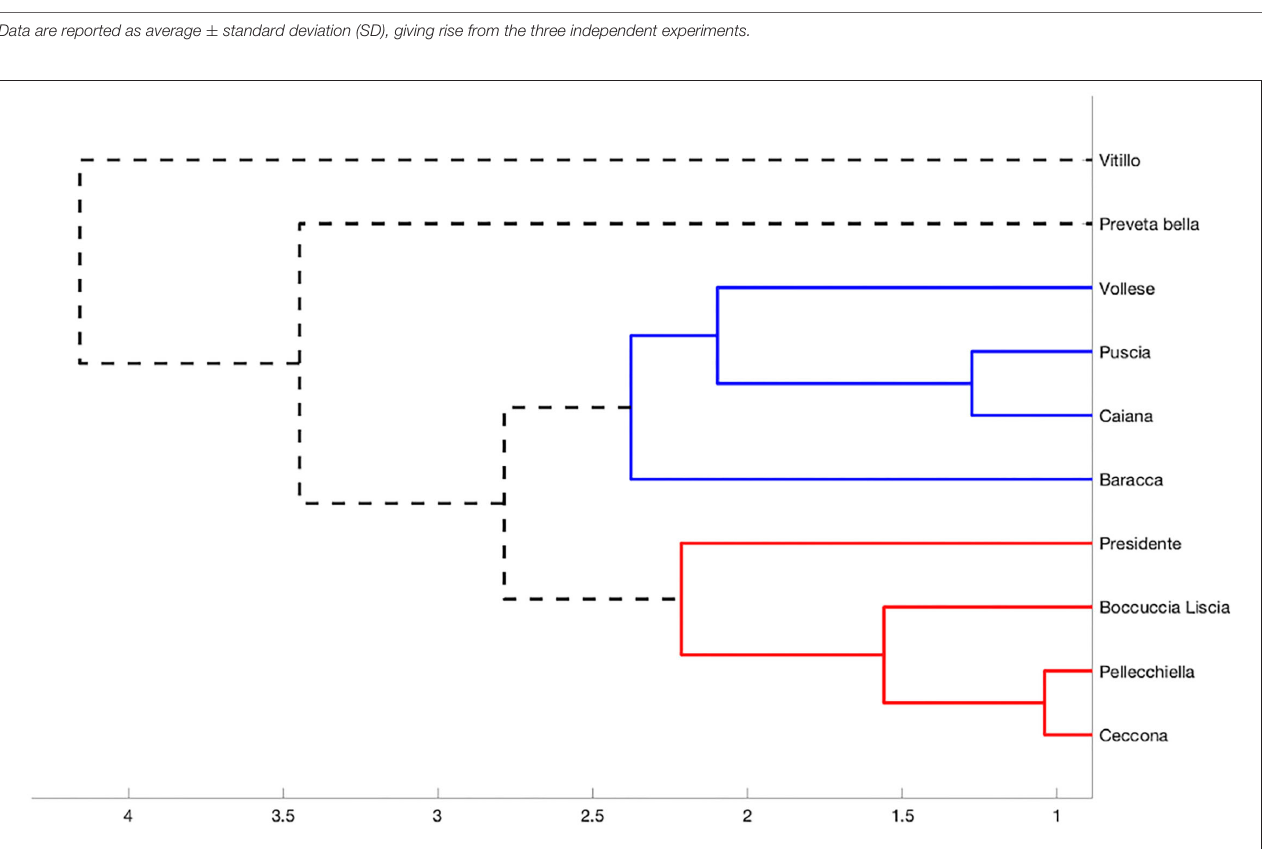
FIGURE 1 | Hierarchical clustering of varieties acquired through a Euclidean unweighted distance and taking into account the normalized content of total polyphenols, ascorbic acid content, β -carotene, and antioxidant activity. We used 2.5 as the cutoff